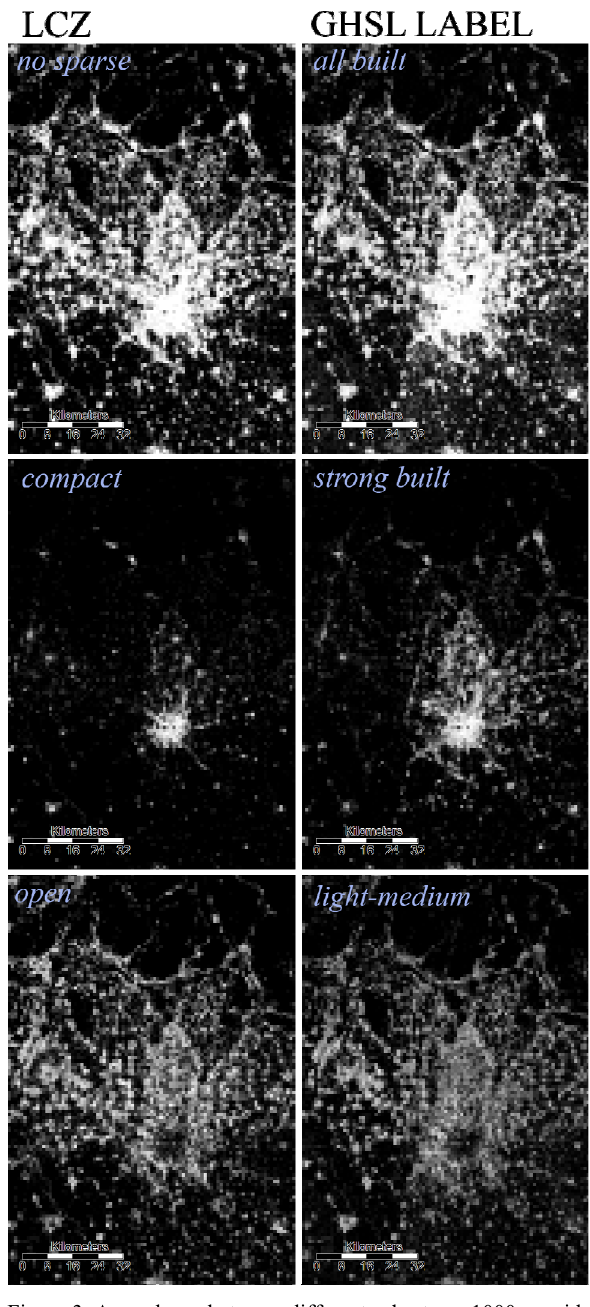
Figure 3. Accordance between different subsets on 1000 m